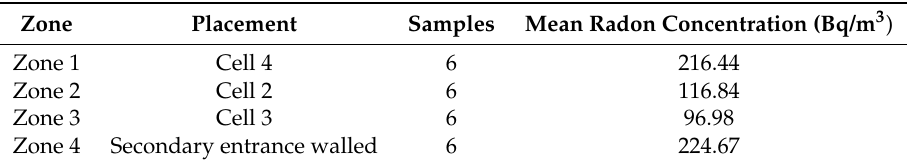
Table 2. Summary mean values of radon concentrations in